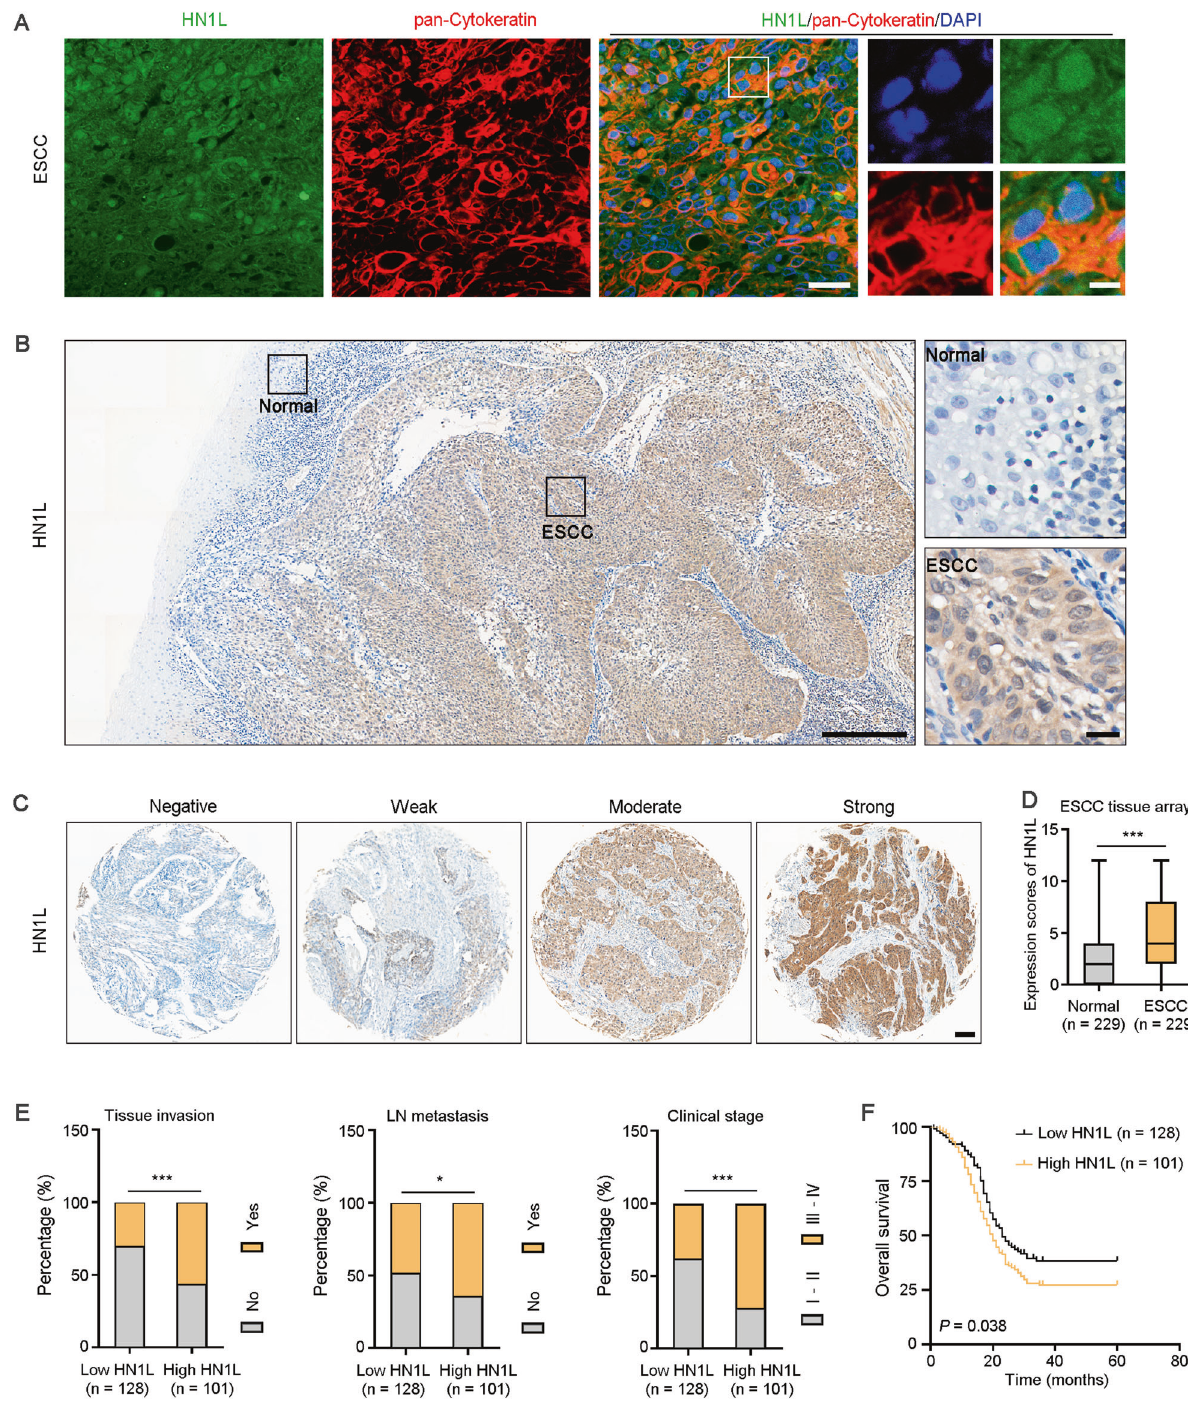
Fig. 1 High expression of HN1L predicates poor prognosis in patients with ESCC. A Double IF staining showed the cellular localization of HN1L in ESCC tissues. Pan-cytokeratin was used to indicate cancer cells. Scale bar, left 20 μ m; right 5 μ m. B Representative image of IHC staining for HN1L in a clinical sample with normal esophageal epithelial tissue and ESCC tissue. Scale bar in left panel, 300 μ m; right panel, 20 μ m. C IHC staining in the ESCC tissue array showed the different expression levels of HN1L. Scale bar, 100 μ m. D Expression scores of HN1L in ESCC tissue array ( n = 229). Data are presented as the mean ± SD; two-sided Student ’ s t test; *** P < 0.001. E Correlation analysis between HN1L expression and clinicopathological data. One-way ANOVA; * P < 0.05, *** P < 0.001. F Kaplan – Meier survival curves showed that a high level of HN1L was associated with poor prognosis in patients with